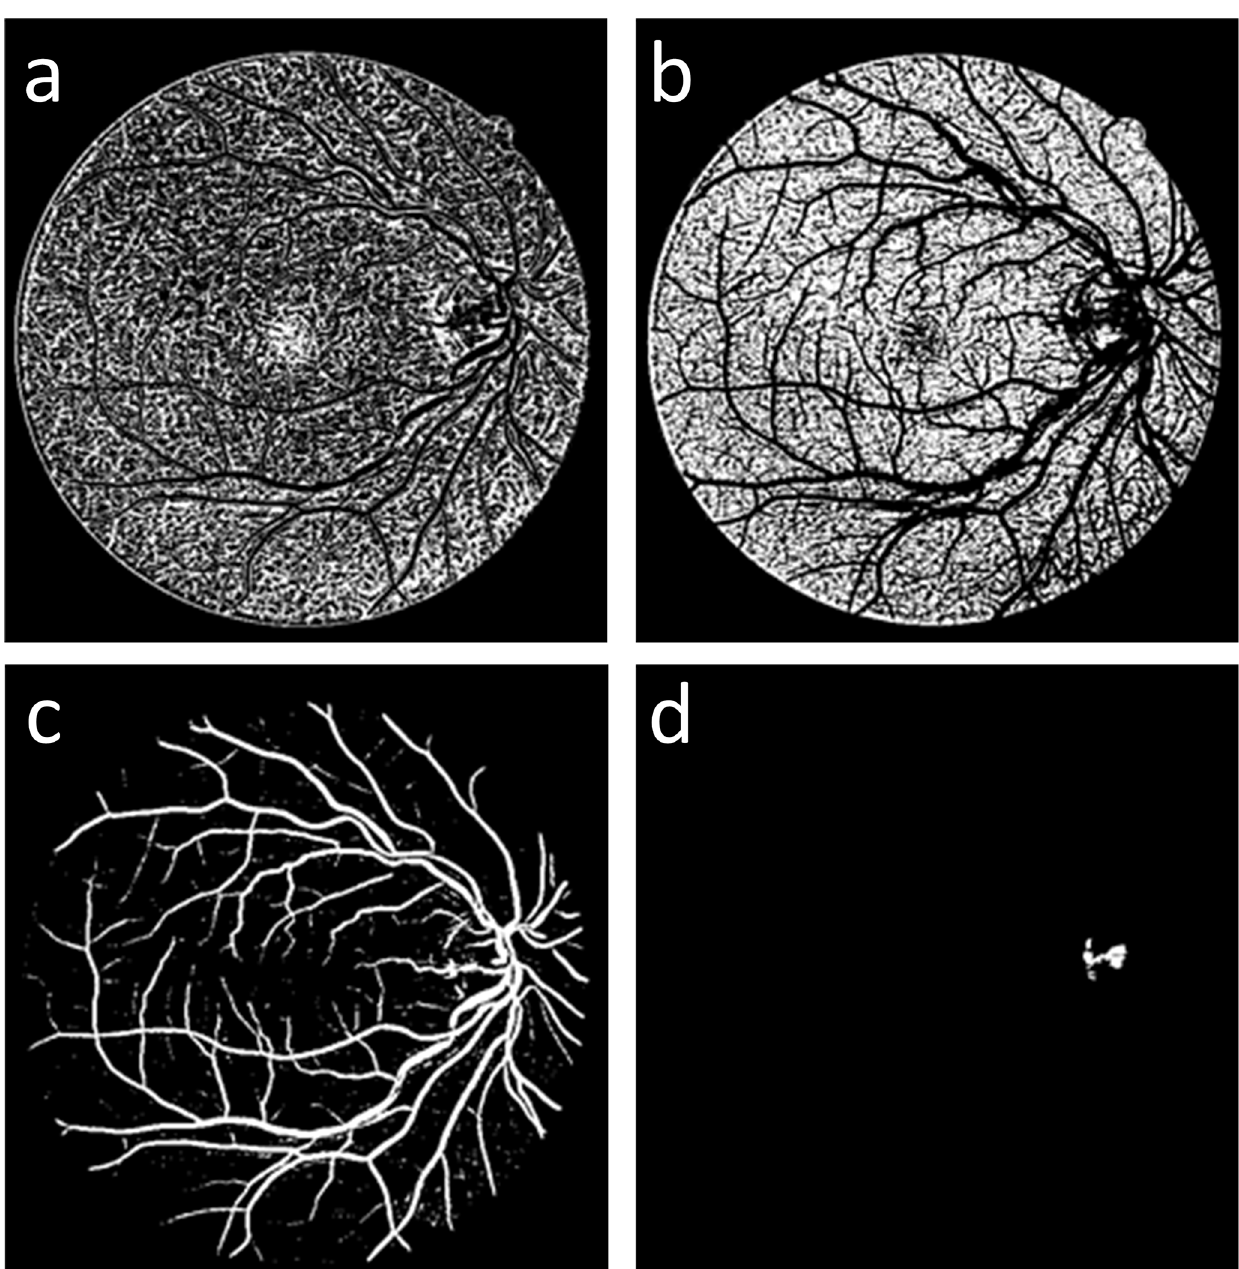
Fig 3. Four clusters from the GMM classifier; (a) and (b) the background clusters, (c) the vessel cluster I GMM and (d) the retinal disc